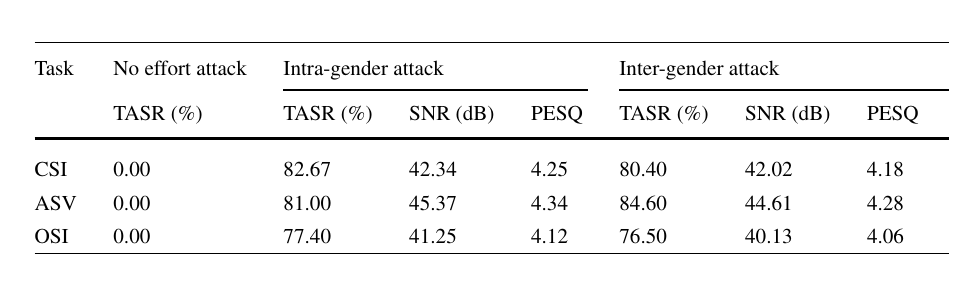
Table 6 Performance of the proposed method for matched attacks on x-vector with d (cid:2) L /3, λ (cid:2) 0.005 and ζ (cid:2) 0.003